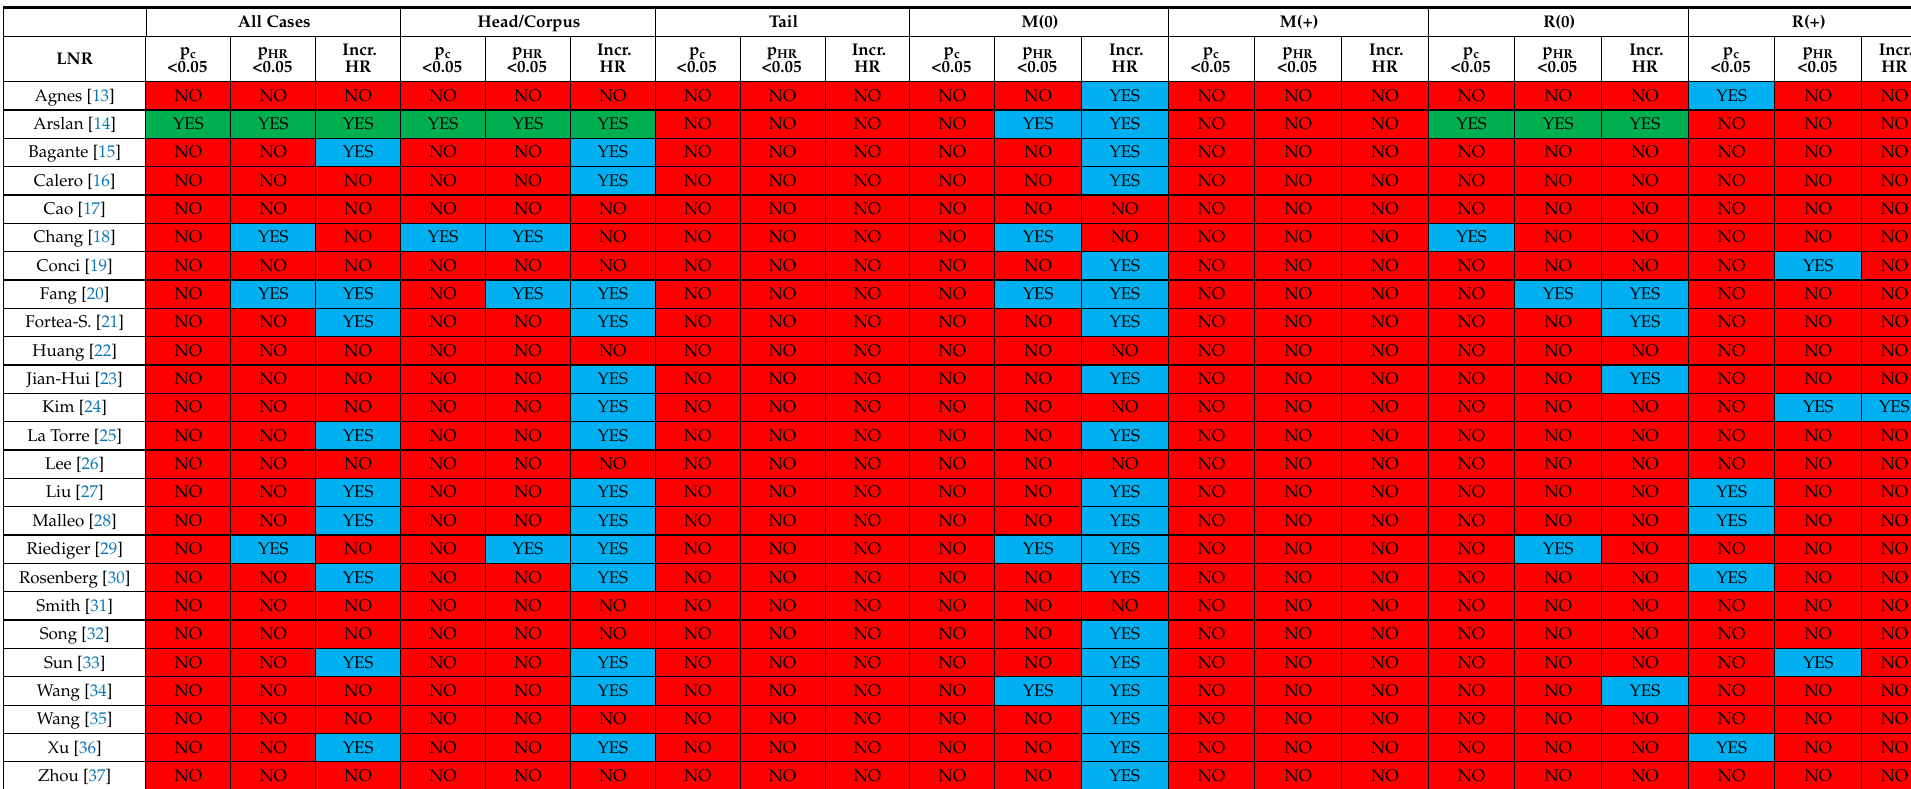
Table 3. Presentation of LNR classifications and their statistical significance (YES/NO) with regard to C statistic (p c ), Cox regression of all subcategories (p HR ), and ascending values of HRs parallel to the assorted risk groups (Incr. HR) for various patient subgroups. Classifications that satisfy an investigated parameter are marked blue, and classifications that satisfy all three investigated parameters are marked